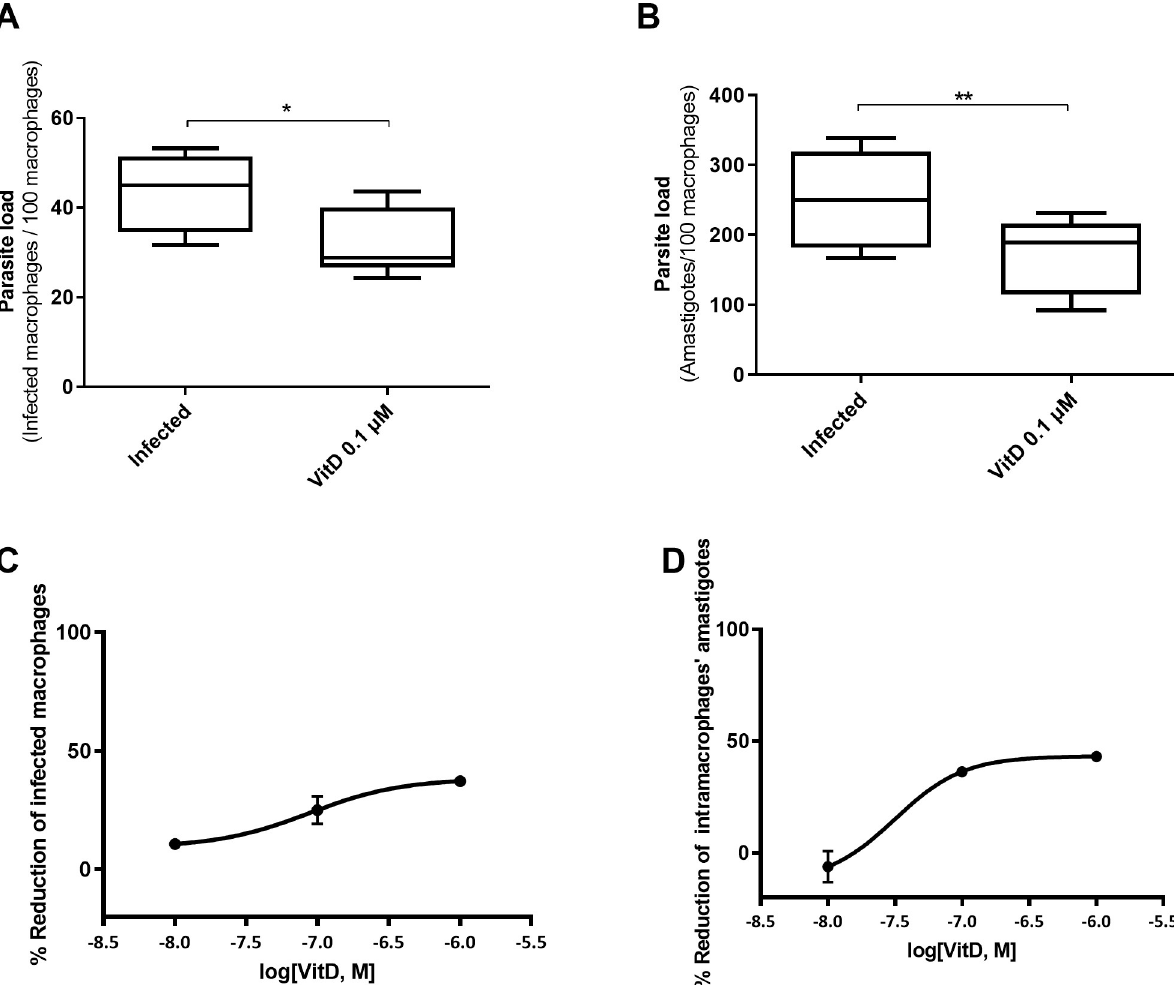
Fig 3. Vitamin D effect on L . infantum parasite load in macrophages. Number of infected macrophages per 100 macrophages ( A ) and amount of intracellular amastigotes per 100 macrophages ( B ) counted in Giemsa stained-preparations from DH82 macrophages infected with L . infantum at ratio 5:1 and pre-treated or not (Control) with 1,25(OH) 2 D at 0.1 μ M 24 h before infection ( � P < 0.05, �� P < 0.01). Dose response curves showing inhibitory rates of L . infantum -infected macrophages ( C ) and intracellular amastigote growth ( D ) after 24h of treatment with 1,25(OH) 2 D based on the values for the untreated